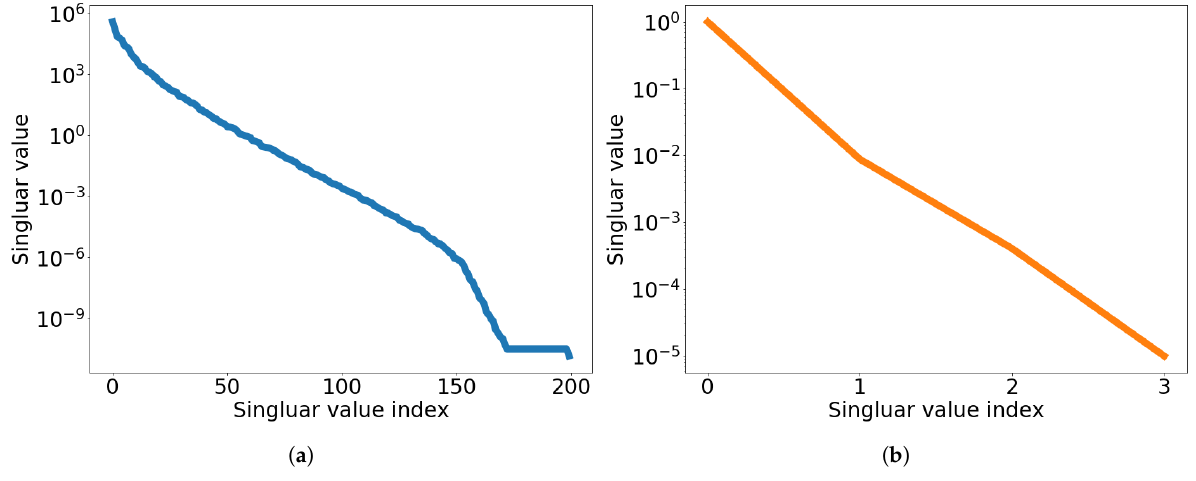
Figure 17. 2D linear convection diffusion equation with source term. Graph of singular value decay. ( a ): Singular value decay of solution snapshot, ( b ): Singular value decay of temporal snapshot for the first spatial basis